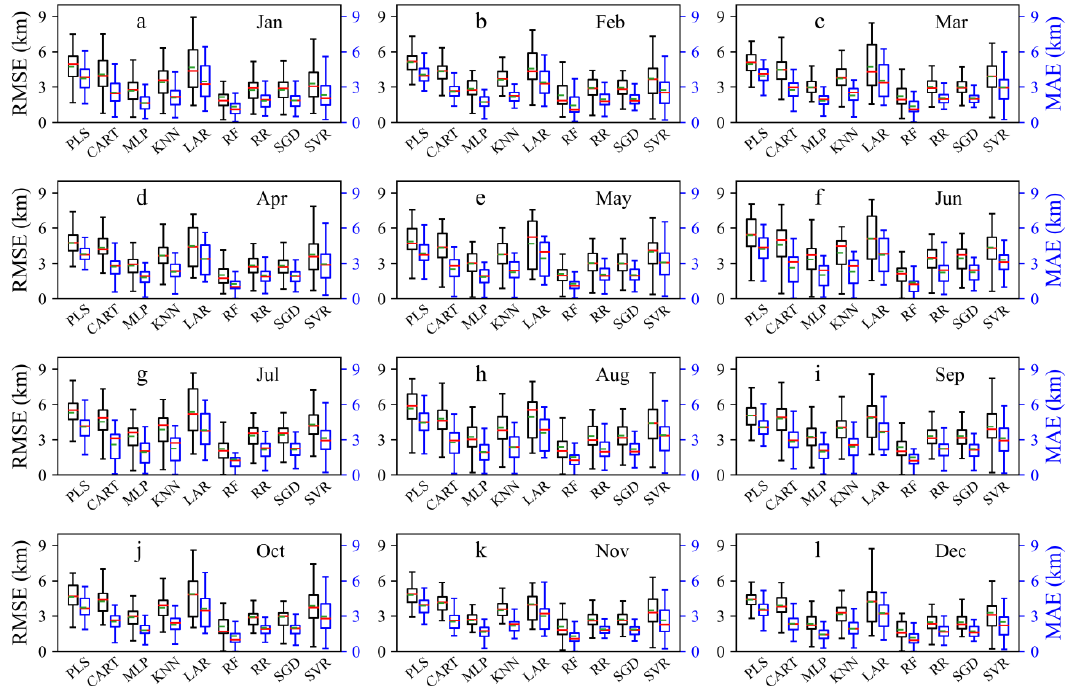
Figure 10. RMSE (black box) and MAE (blue box) between hourly visibility observations and estimates at 47 airports in the testing period (2020).